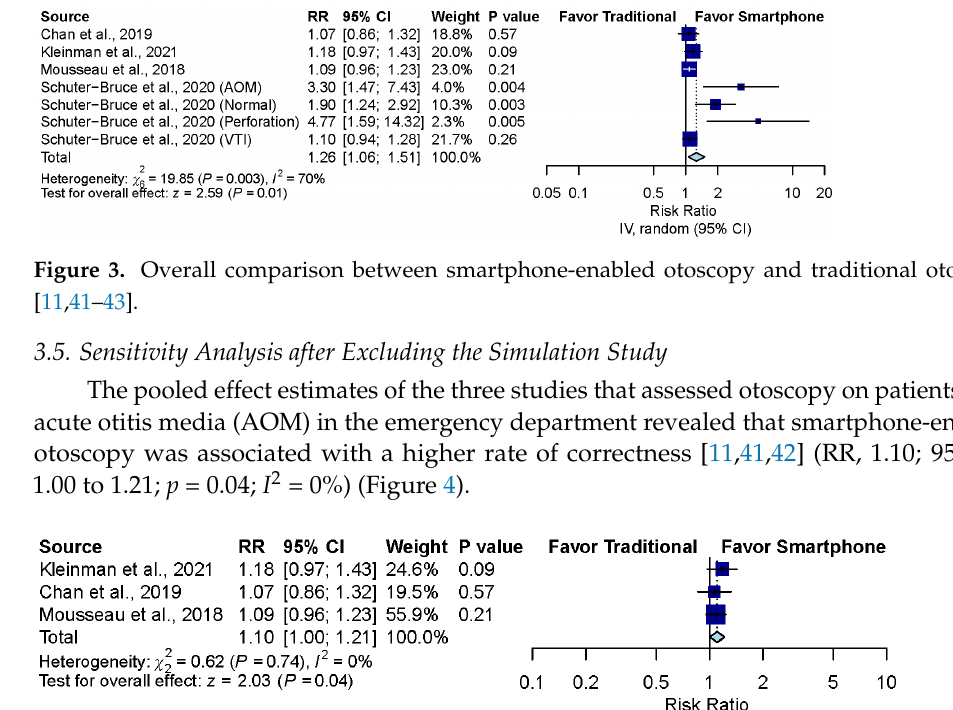
Figure 5. Sensitivity analysis after excluding normal ear conditions. 3.7. Confidence Comparison between Smartphone-Enabled Otoscopy and Traditional Otoscopy Considering the two studies that reported the confidence of examiners using both otoscopy methods [11,43], the pooled result was nonsignificant between the smartphone-